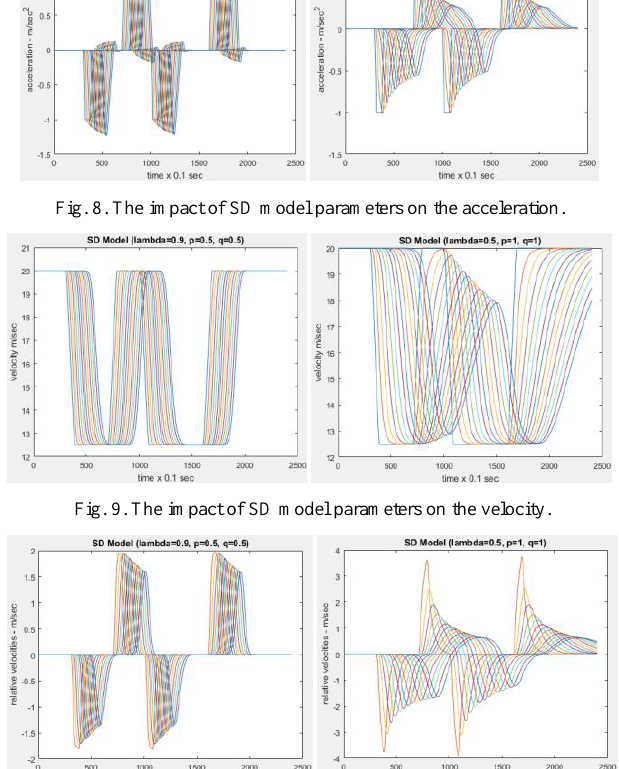
Fig. 10. The impact of SD model parameters on the relative velocity.